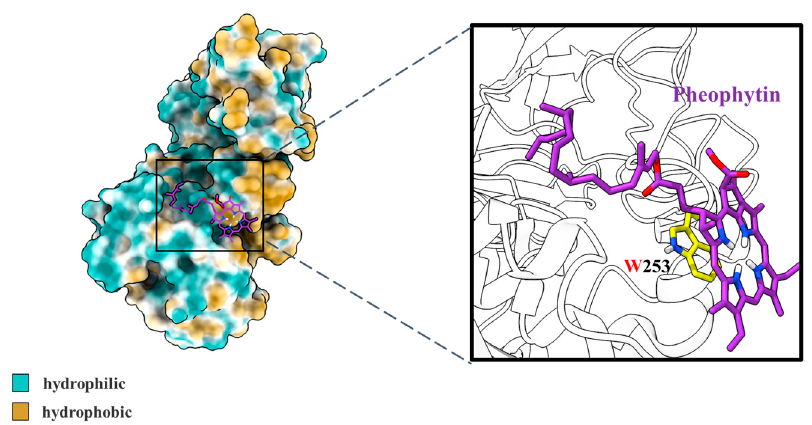
Figure 7. Conformational analysis of molecular docking results for pheophytin and pancreatic lipase. The structure of pheophytin was drawn as sticks, while the structure of lipase was drawn as the surface. The hydrophilic and hydrophobic groups of pancreatic lipase were painted cyan and yellow, respectively. The solid frame area presented a close-up view of the binding site for pancreatic lipase and